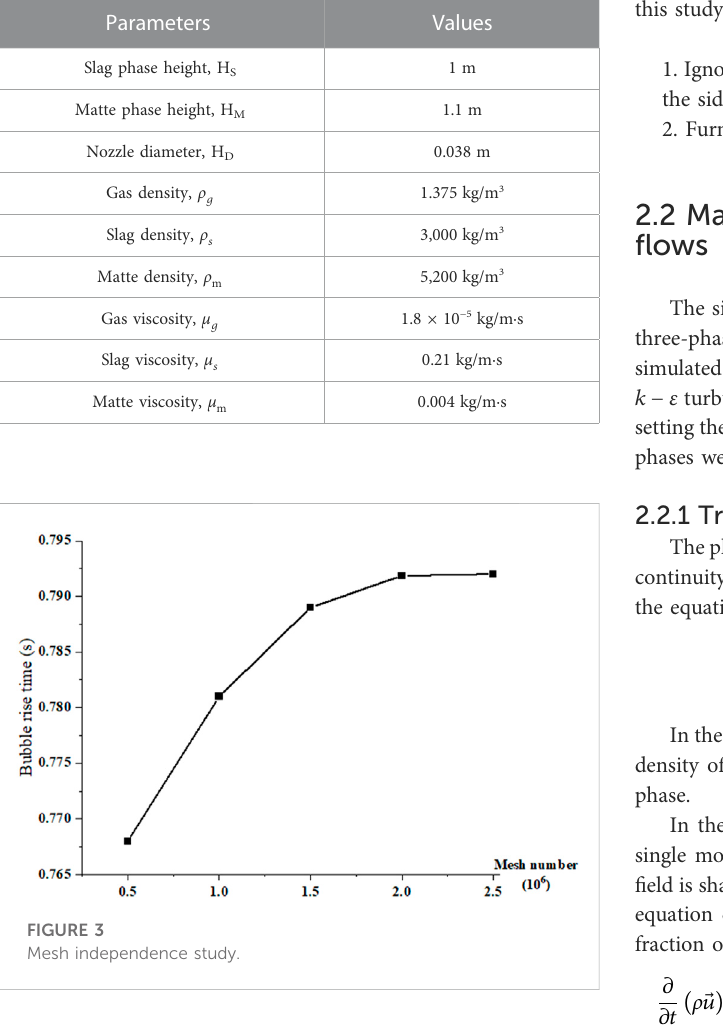
into three regions: the upper fl ue gas region, the middle slag phase